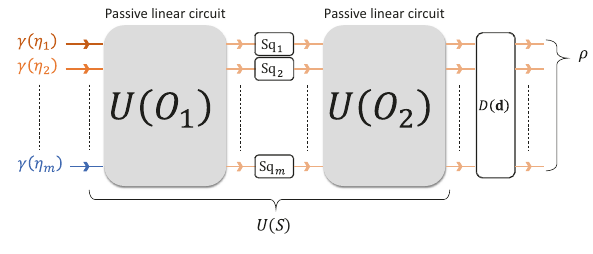
Fig. 4 Williamson and Euler (or Bloch – Messiah) decompositions. These methods allow a generic m -mode Gaussian state ρ to be prepared systematically from m uncorrelated single-mode thermal states, represented here by γ η k ð Þ . Each Sq k is a single-mode (cid:1) (cid:3) squeezing operation, while the U O j are passive linear unitaries; D ( d ) is a phase-space displacement